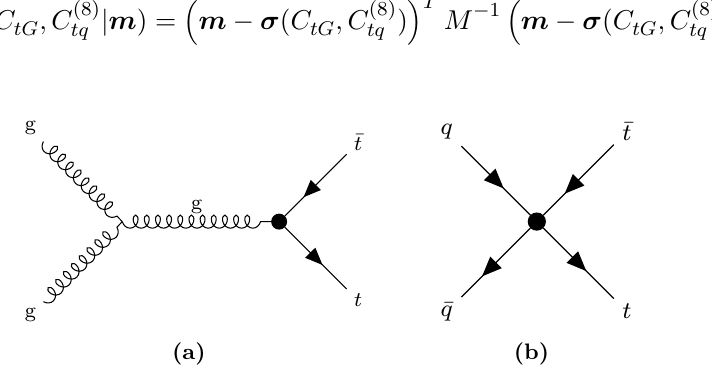
and (b) C (8) . tG tq